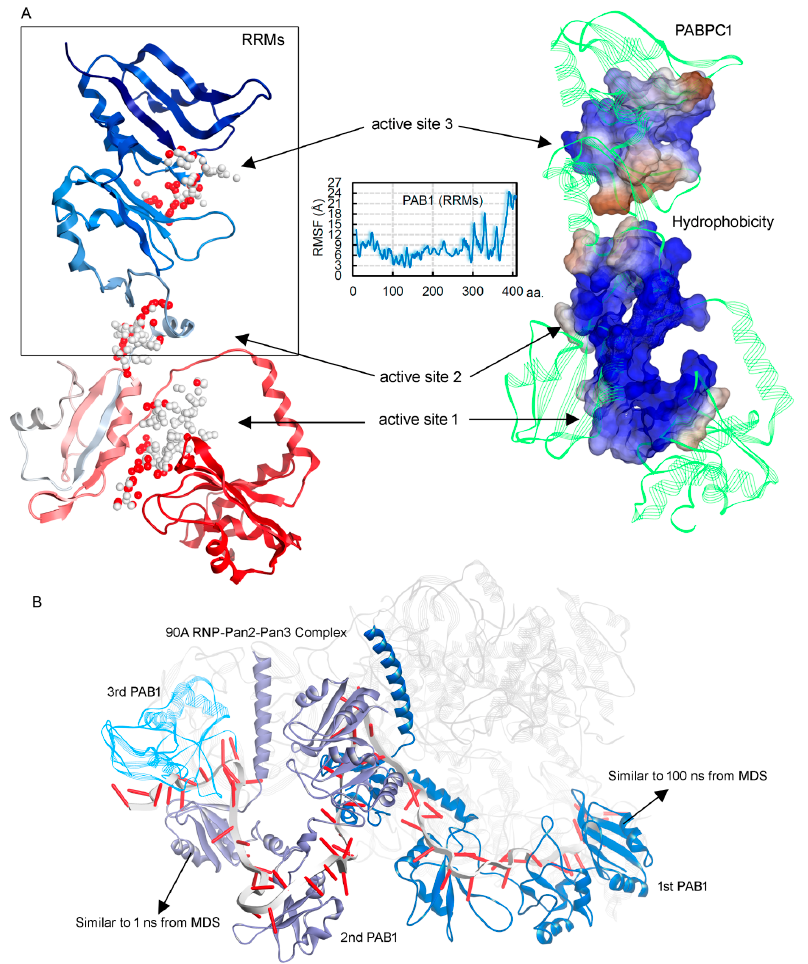
Figure 7. Predicted active sites over the modeled PABPC1 structure that was retrieved at the end of MD simulation, using the “Alpha Shapes” construction geometric method [18]. ( A ) Three large sites were found using this “Alpha Shapes” approach. The center RMSF plot represents the RRM3–4 domain residues having high flexibility due to conformational switch within the protein structure. The right panel describes the hydrophobicity (blue for hydrophilic and brown for hydrophobic) of the active sites. ( B ) The cryo-EM structure describing multiple binding conformations of the PABPC1 protein in the 90A RNP-Pan2-Pan3 complex (pdb id.: 6r5k [14]). These conformations resemble our simulated PAB1 model, i.e., from the beginning and end of MD simulations. Table 1. Active site predicted over the PABPC1 modeled structure using the “Alpha Shapes” con- struction geometric method [18] implemented in the MOE (Chemical Computing Group Inc., Mon- treal, QC, Canada) package.